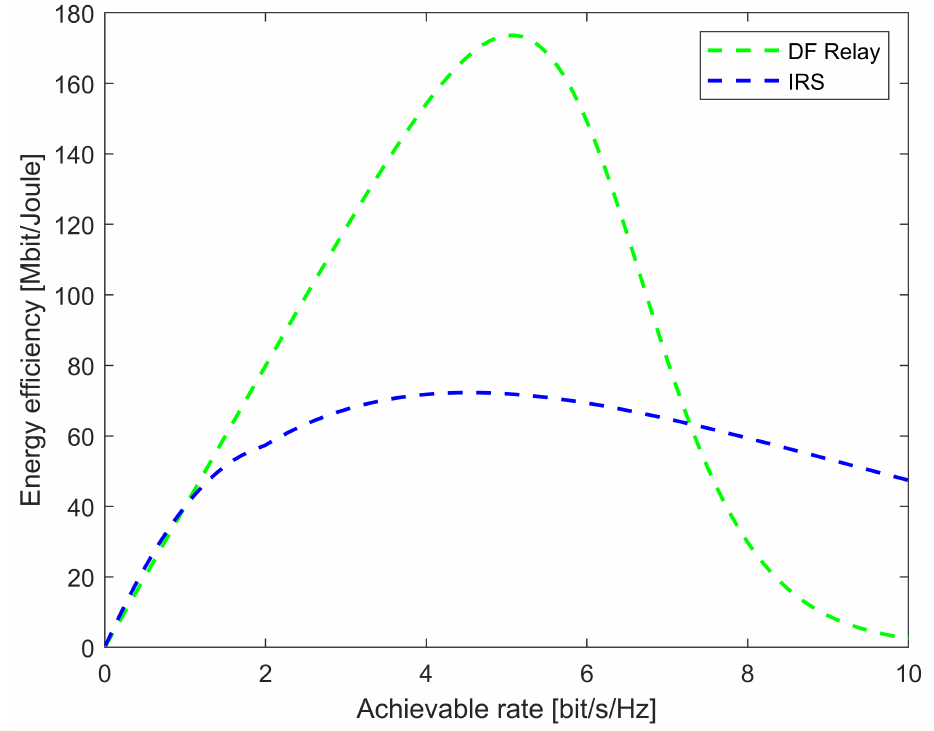
Figure 5. The comparison between energy efficiency and data rate for DF relay and